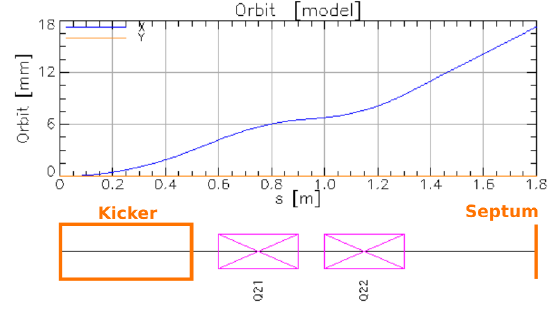
Figure 7. Deflected orbit during propagation from kicker magnet to septum magnet of Multiplexer setup. 12mrad angular deflec- tion at the kicker result in 18mm o ff set at the septum position. Note the e ff ect of feed-down dipolar kicks from the quadrupole